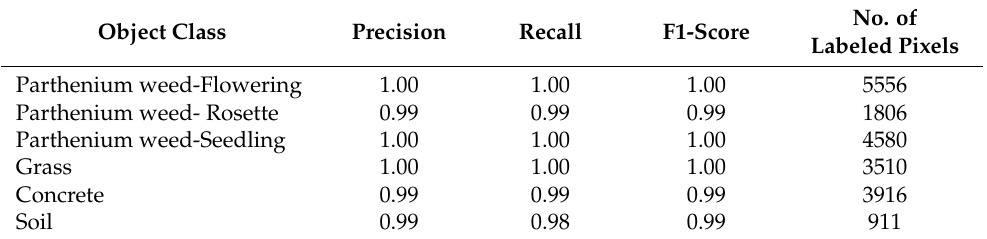
Table 4. Performance metrics of the XGBoost as a hyperspectral pixel classifier.